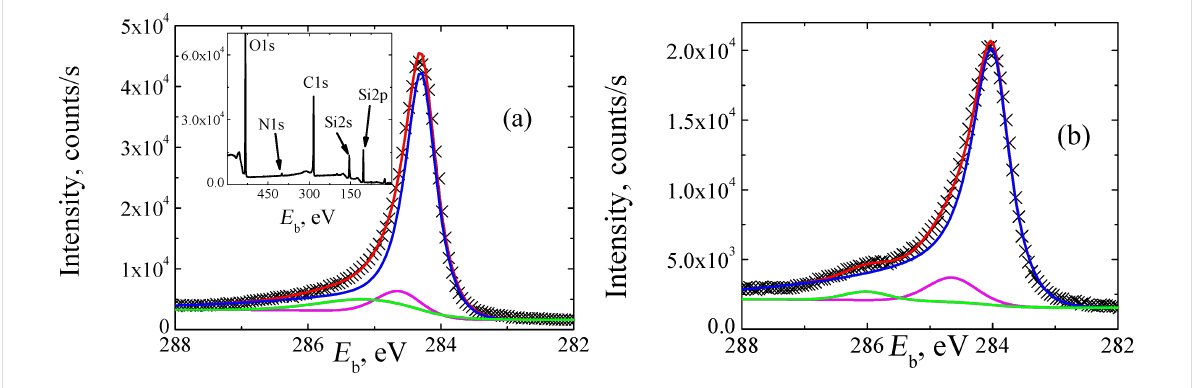
Figure 9: High-resolution C 1s XPS spectra of samples on a SiO 2 /Si substrate. (a) Raw data sample A (black crosses). Blue, magenta and green lines are the result of the fitting procedure. The red line corresponds to the envelope of the fitted peaks. Inset: XPS survey spectrum. (b) Raw data sample B (black crosses). Blue, magenta and green lines are the result of the fitting procedure and the red line corresponds to the envelope of the fitted peaks.